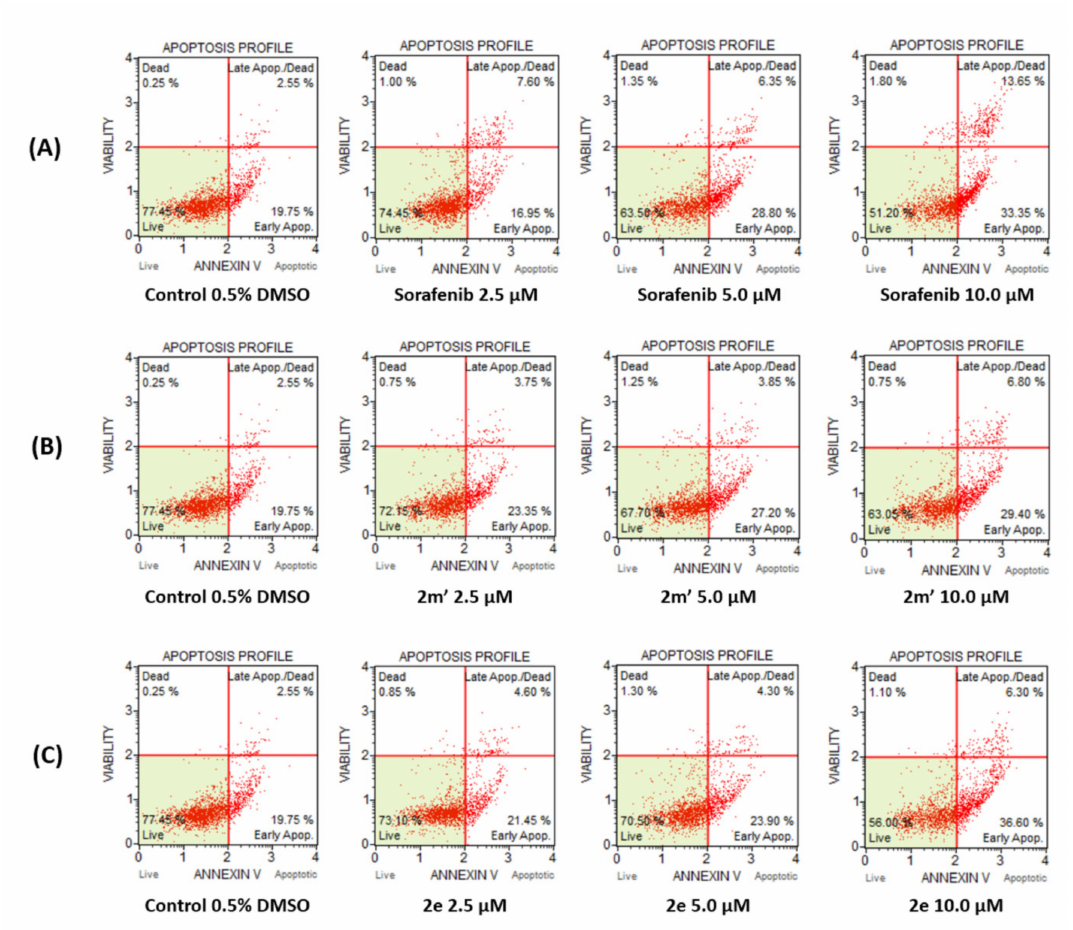
Figure 5. The detection of apoptosis, concentration-dependent for 48 h, by compounds ( A ) Sorafenib, ( B ) 2m’ , and ( C ) 2e in HepG2 cells, compared with 0.5% DMSO as a